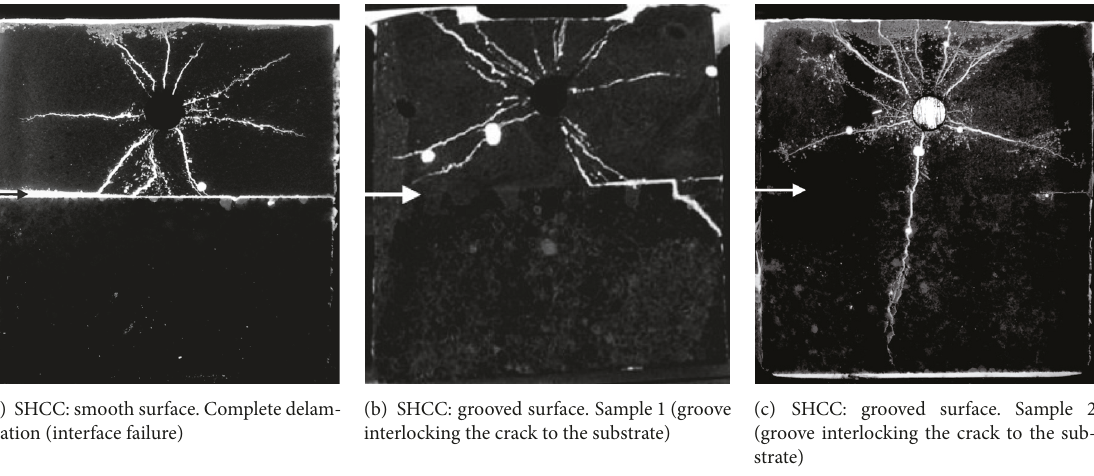
Figure 15: Experimentally obtained damage patterns when SHCC is used as a repair material (top: repair material; bottom: mortar substrate; interface is indicated with the arrow); samples are epoxy impregnated and imaged under UV light.